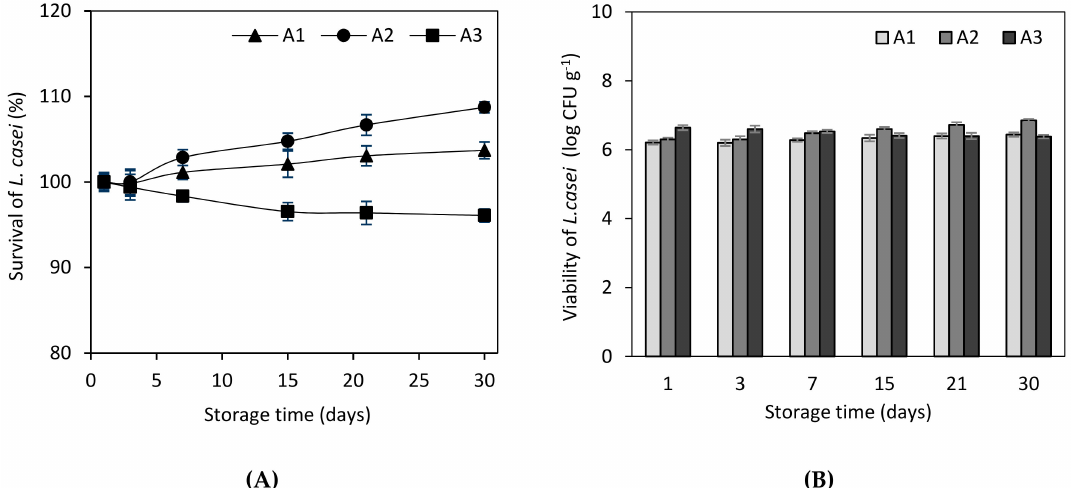
Figure 1. Viability of the immobilized probiotic cells ( L. casei ATCC393 immobilized on Pistacia terebinthus resin) added at various concentrations (A1: 0.3 g, A2: 0.6 g, and A3: 1.2 g per 100 mL of whey) during whey beverages cold storage (4 ◦ C) for 30 days (viability expressed as ( A ) % survival and ( B ) log cfu gr − 1